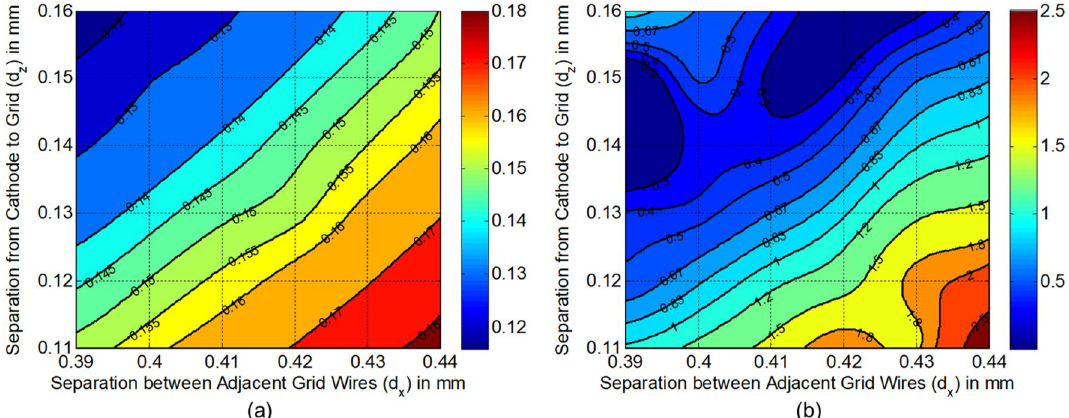
Figure 13. ( a ) Variation of beam current with d z and d x . ( b ) Variation of beam aspect ratio (x/y) at the beam waist in y direction with d z and d x .